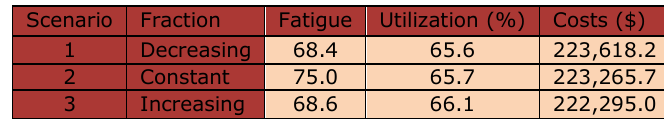
Table 13. Three Scenarios with Different Loading